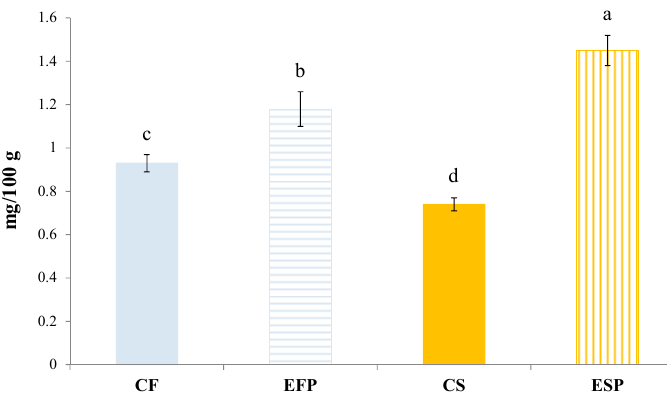
Figure 2. Lysine content of final breads. Abbreviations: CF, control bread prepared from wheat flour; EFP, experimental bread prepared from wheat flour + 5% ( w / w ) of pistachio powder; CS, control